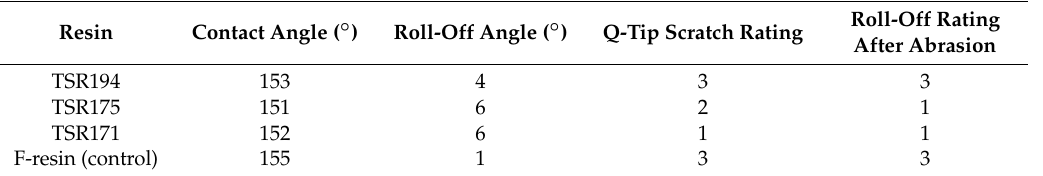
Table 3. Properties of the superhydrophobic coatings based on modified silicone resin and fluorine- functionalized colloidal silica.